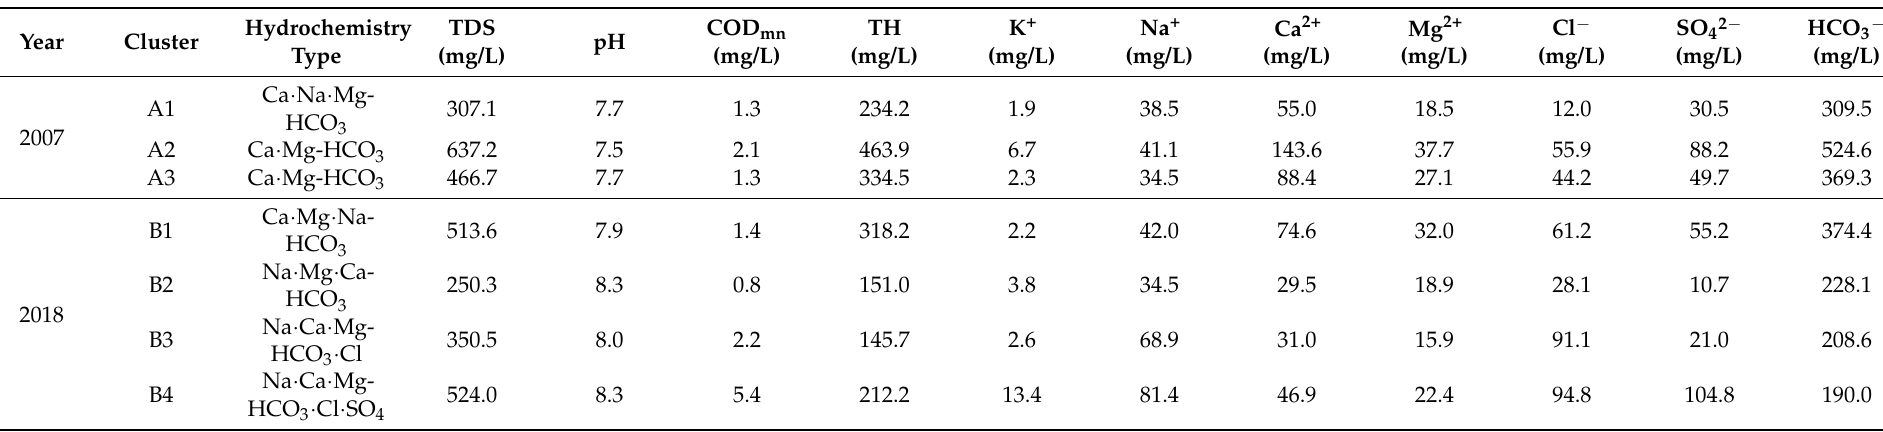
Table 1. Average hydrochemical data for clusters from hierarchical cluster analysis (HCA) in September 2007 and May